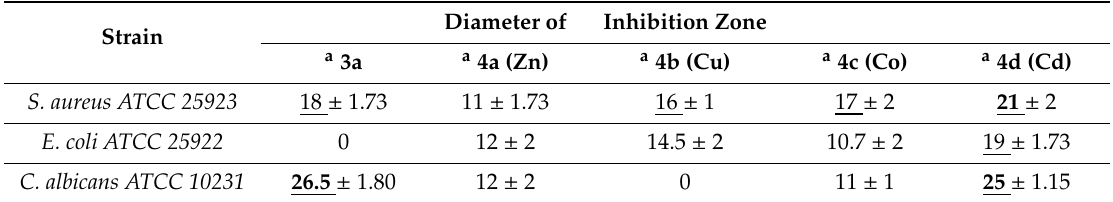
Underline means active and bold and underline means very active. a Diameter of inhibition zone measurements ± standard deviation. (mm), a X ± SD, mean of five measurements ± standard deviation.